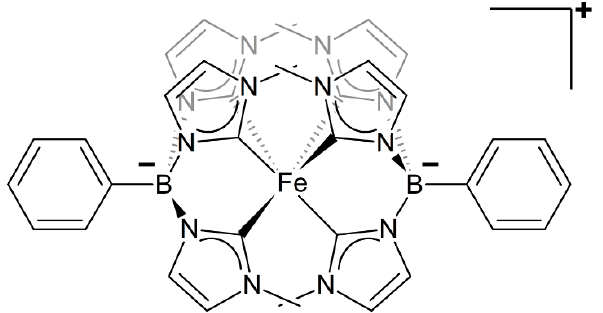
Figure 1. Chemical structure of the Fe III complex [Fe(phtmeimb) 2 ] + studied in this work. The iron center is coordinated with six imidazole rings through six Fe-C bonds. The rings in the background are shown in light gray.